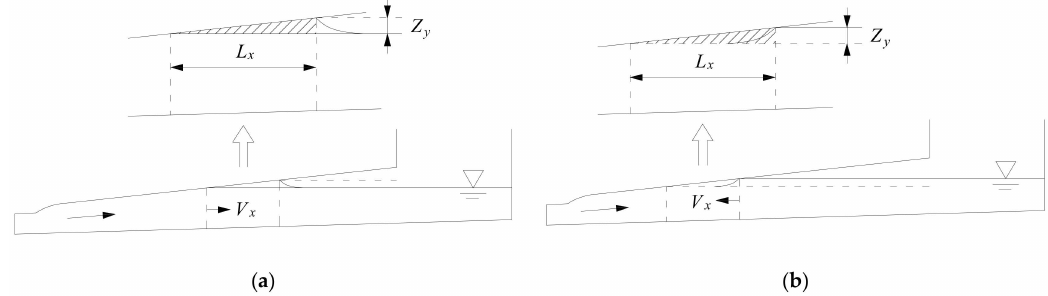
Figure 21. Interface movement of FSPF in an SCTT. ( a ) Hammer water wave, ( b ) retreated water wave. Reproduced with permission from [39], Elsevier,